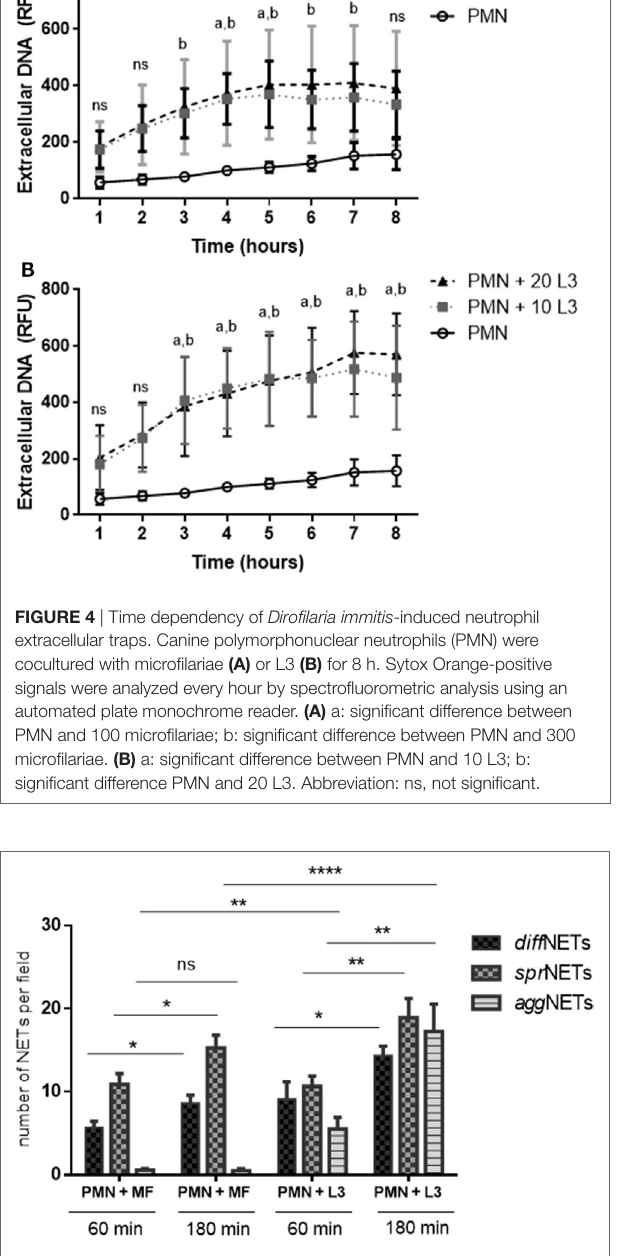
FigUre 5 | Quantification of different types of neutrophil extracellular traps (NETs) induced by Dirofilaria immitis stages . Canine polymorphonuclear neutrophils (PMN) ( n = 3, 2 × 10 5 ) we exposed to microfilariae (MF; 50 larvae) and L3 (10 larvae) on poly- l -lysine pre-coated coverslips for 1 and 3 h. After fixation, immunofluorescence analysis was performed using Sytox Orange as DNA-marker along with anti-histone antibodies. The types of NETs ( diff NETs, spr NETs, and agg NETs) were identified microscopically and counted.